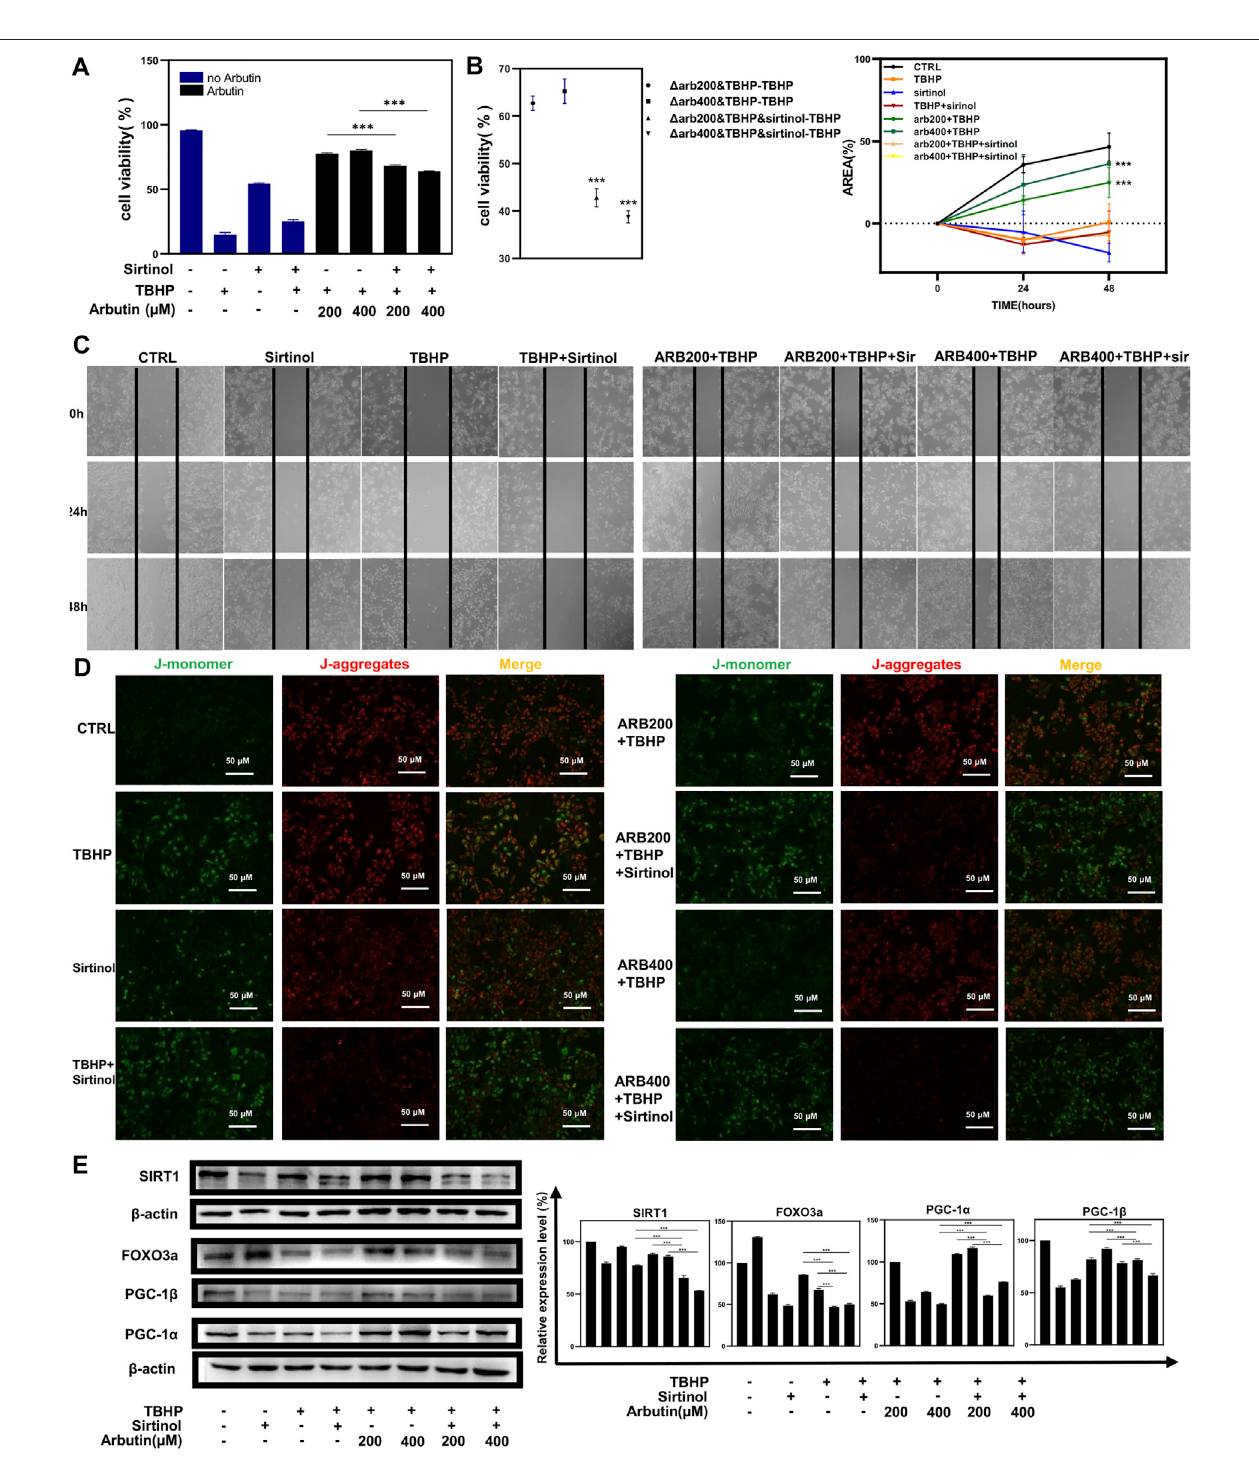
FIGURE5| SirtinoldiminishedthecapabilityofArbutintoassistARPE-19cellstodefendagainstoxidativestress. (A)(B) fl owcytometricanalysisshowedthatcells treatedwithonlysirtinol,TBHP,cotreatedwithsirtinol,andTBHPdisplayeddecreasedcellularviability.However,sirtinolconductiondiminishedtheprotectivecapacityof Arbutin. (C) ARPE-19 cells were seeded in a 24-well plate and applied wounds at the con fl uence of 80%. The cells were pretreated with or without Arbutin and then subjectedtoTBHP(350 µM);meanwhile,cellsincertaingroupswereincubatedwithsirtinol.Photosweretakenatdifferenttimepointspostdistincttreatments. (D) fl uorescence images observed that ARPE-19 treated with Arbutin while subjected to sirtinol and then exposed to TBHP was unable to recuperate ΔΨ m. (E) with sirtinol administration, the protein levels of the SIRT1/FOXO3a/PGC-1 α / β pathway decreased in the presence of Arbutin (* p < 0.05, ** p < 0.01, *** p < 0.001, n = 3, bars represent